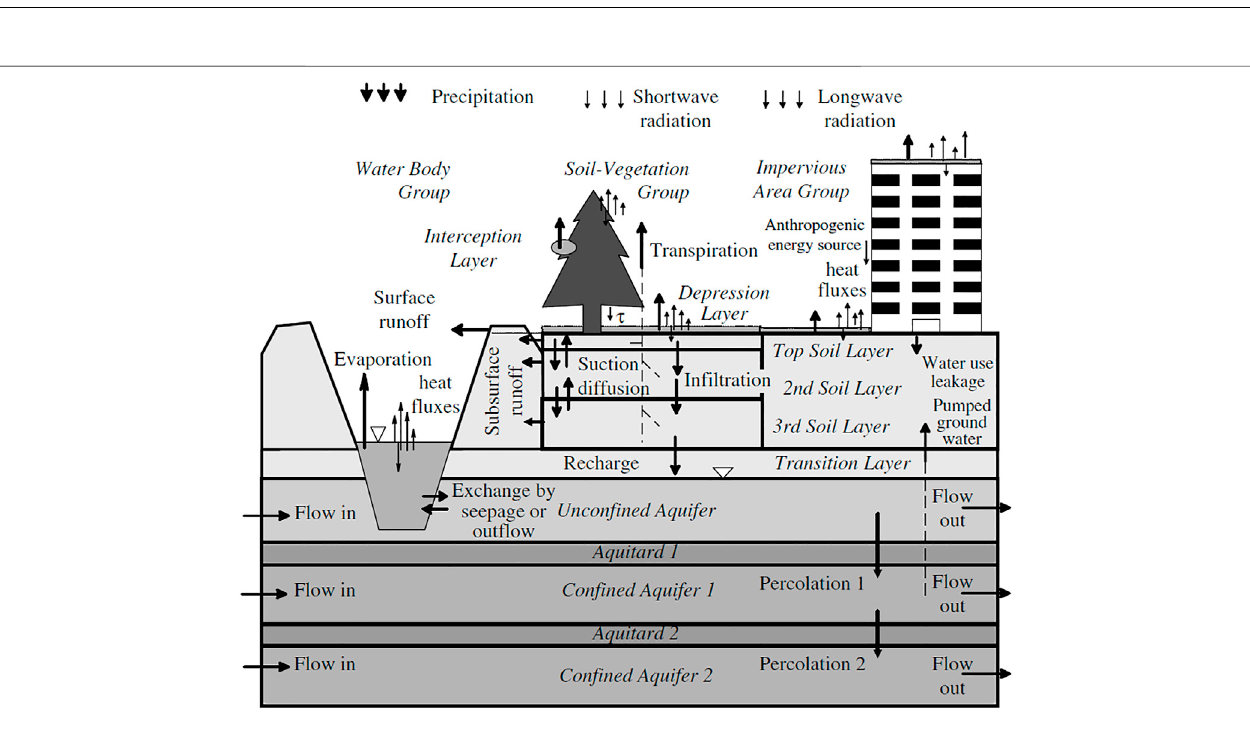
FIGURE 2 | Schematic illustration of WEP model vertical structure within a grid cell.